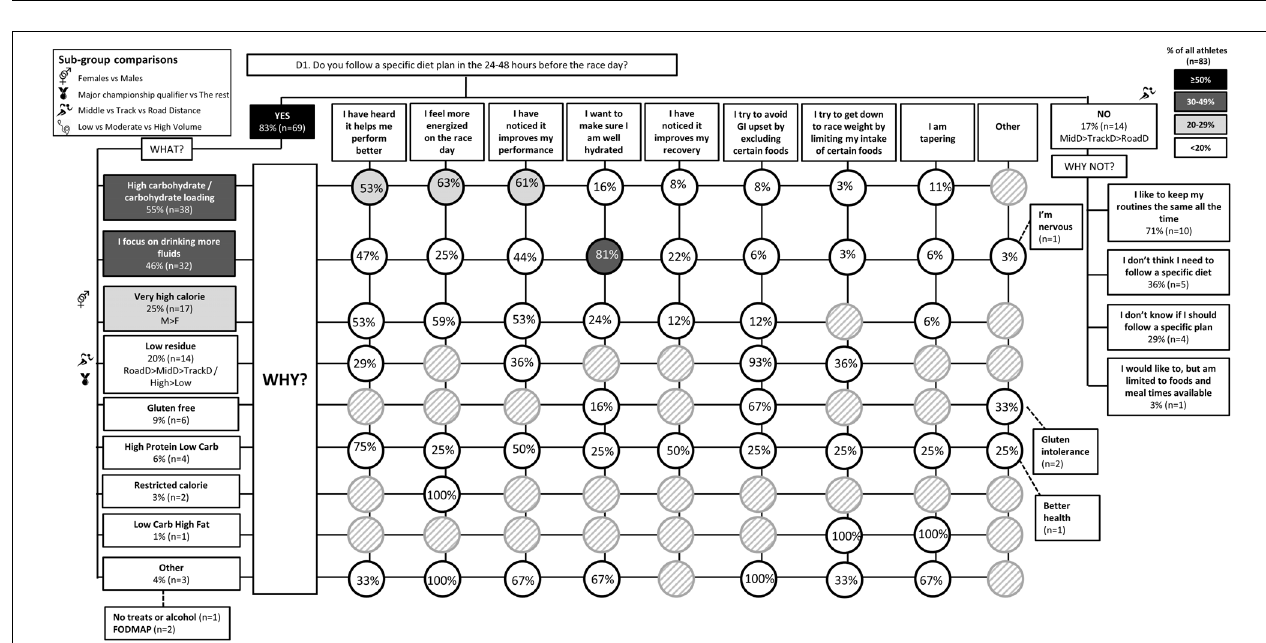
FIGURE 9 | D1: Nutrition in the 24–48h time period before the race. The prevalence of specific nutrition strategies and the reasons for them in 83 elite female and male track and field endurance athletes within the acute time period preceding the main race. Please see full description for figure within Figure 1 .